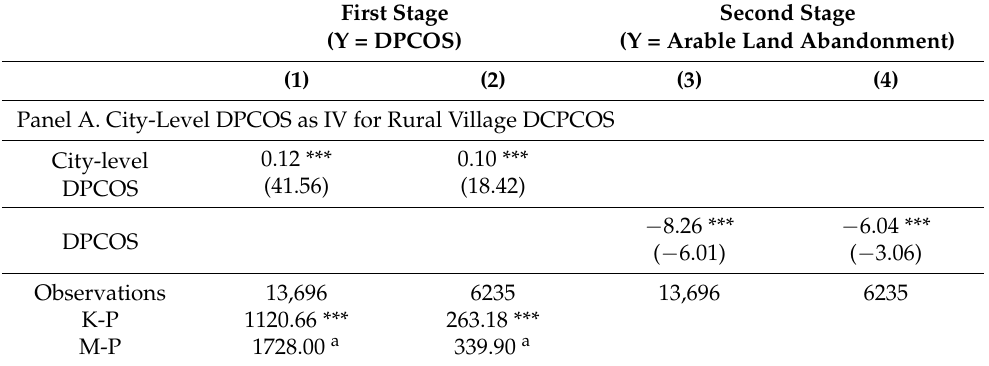
Table 5. Estimate results from augmented